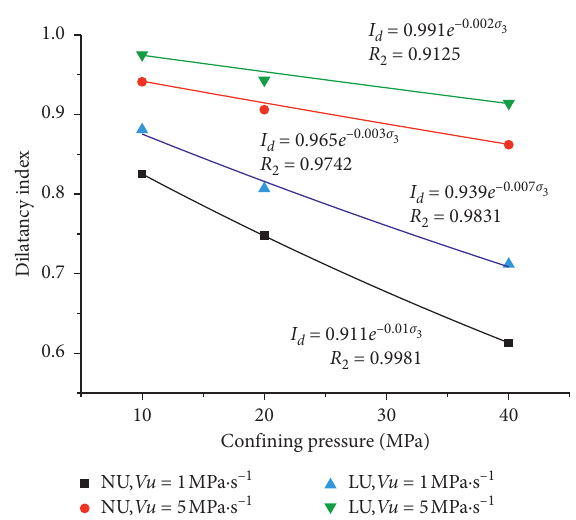
Figure 10: Relationship between the dilatancy index and confining